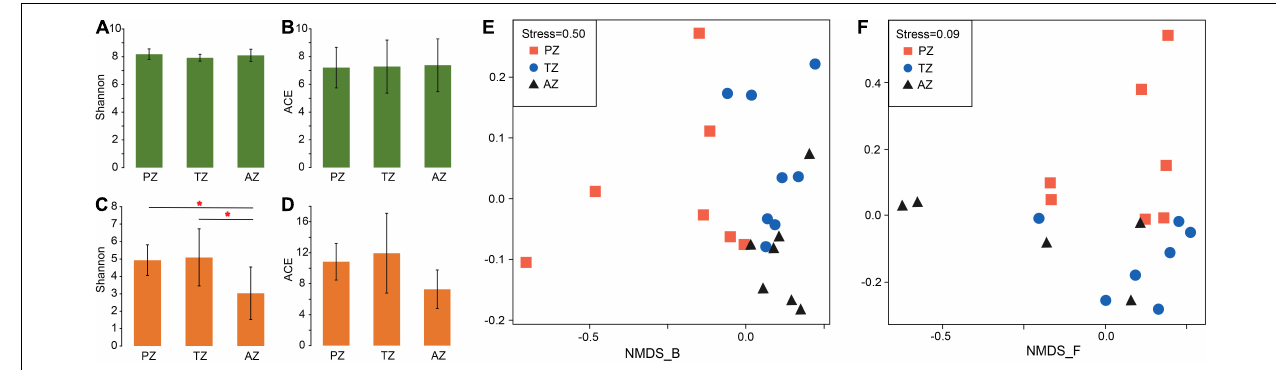
FIGURE 1 | Alpha-diversity indices and non-metric multidimensional scaling (NMDS) analysis of bacterial (A,B,E) and fungal (C,D,F) communities of weathered rocks in the Heshang Cave, Hubei province, China. PZ: photic zone; TZ: twilight zone; AZ: aphotic zone. The mark with * indicates significant differences between the two groups ( P < 0.05).